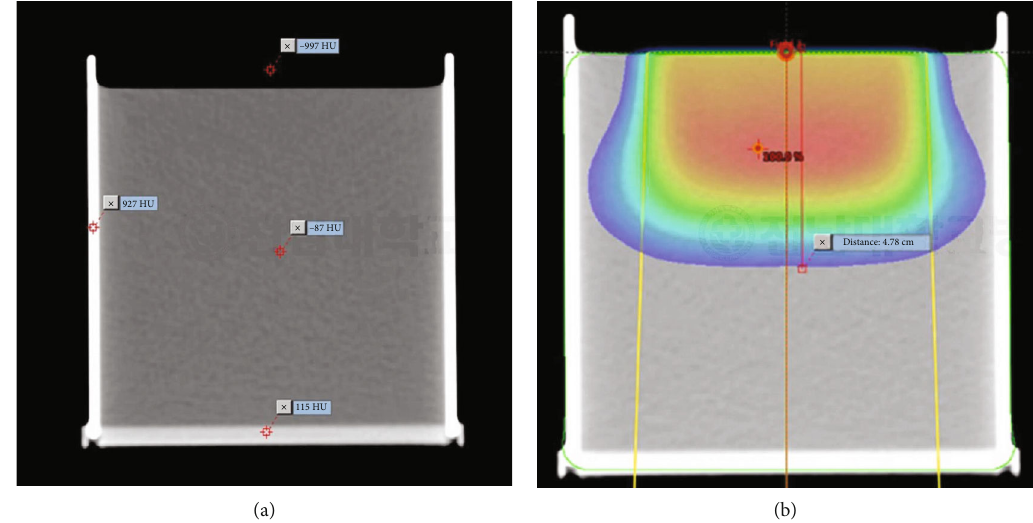
Figure 9: (a) HU value of NE3 sample after taking General Electric CT image. (b) A simulated image of NE3 with 9 MeV electron beam from Varian Novalis Tx. The vertical yellow lines represent the line of the cone used to prevent electron beams from spreading